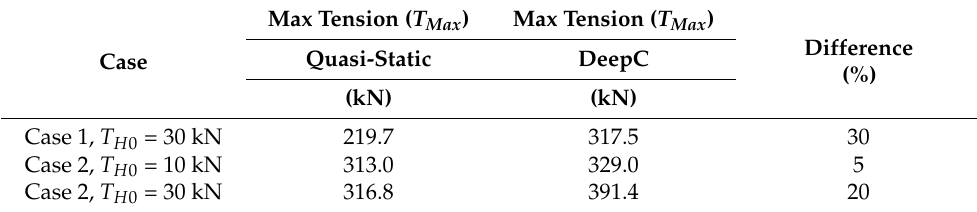
Table 20. Difference of maximum line’s tension between quasi-static and couple analysis.